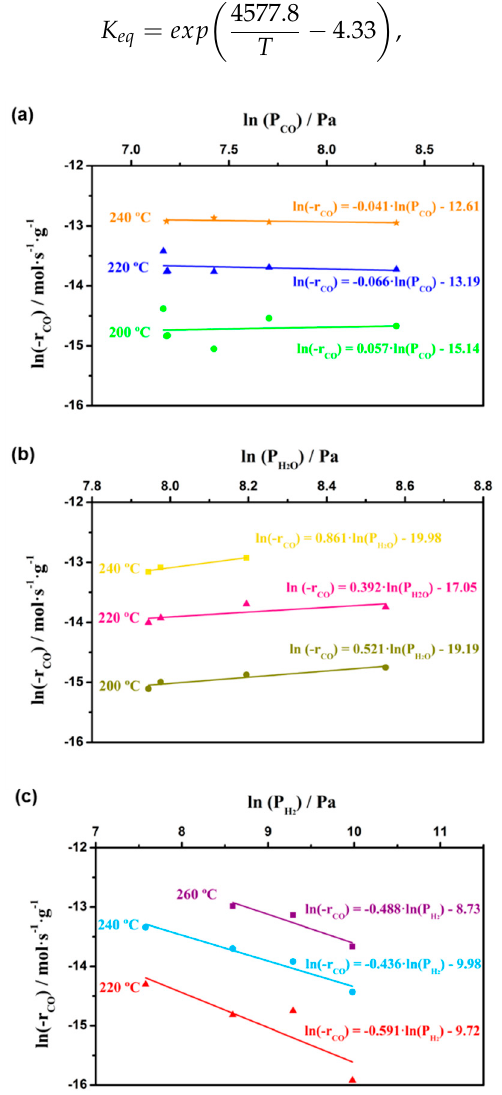
Figure 1. Variation of WGS reaction rates on PtCeAl + ZrEuMo (1:5) for CO conversions below 20% with the different tested partial pressures: ( a ) variation of CO partial pressure (tests CO_1, CO_2, CO_3 and references), ( b ) variation of H 2 O partial pressure (tests H 2 O_1, H 2 O_2 and references), and ( c ) variation of H 2 partial pressure (tests H 2 _1, H 2 _2, H 2 _3, H 2 _4 and references).